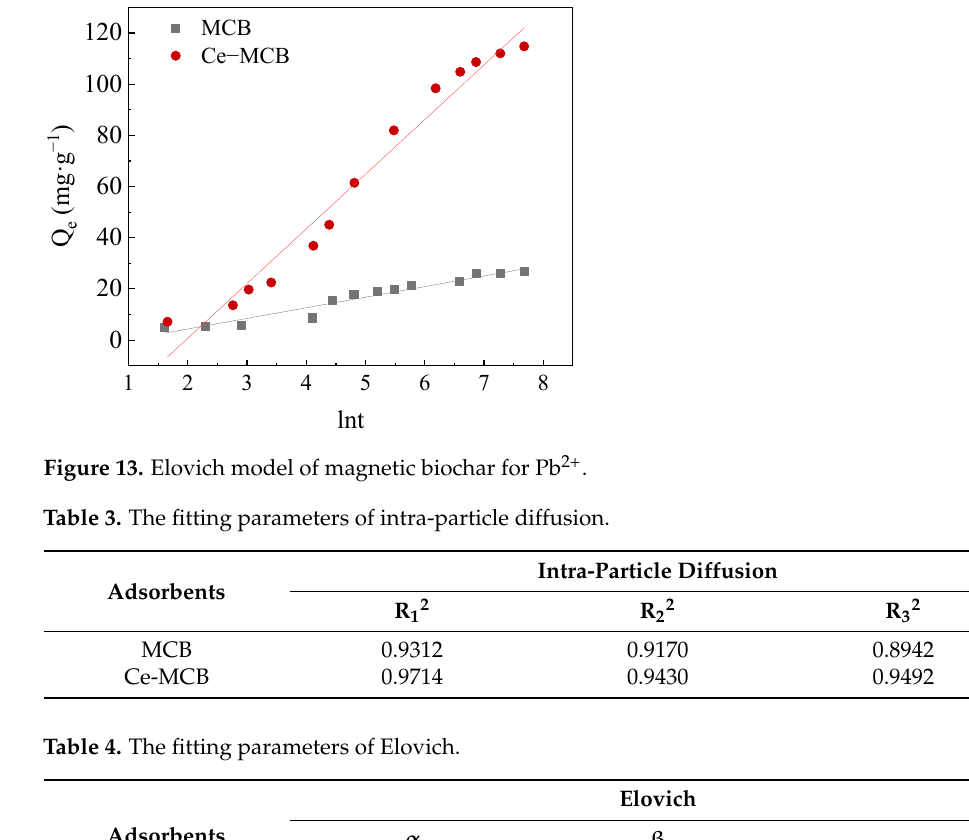
Table 3. The fitting parameters of intra-particle diffusion.